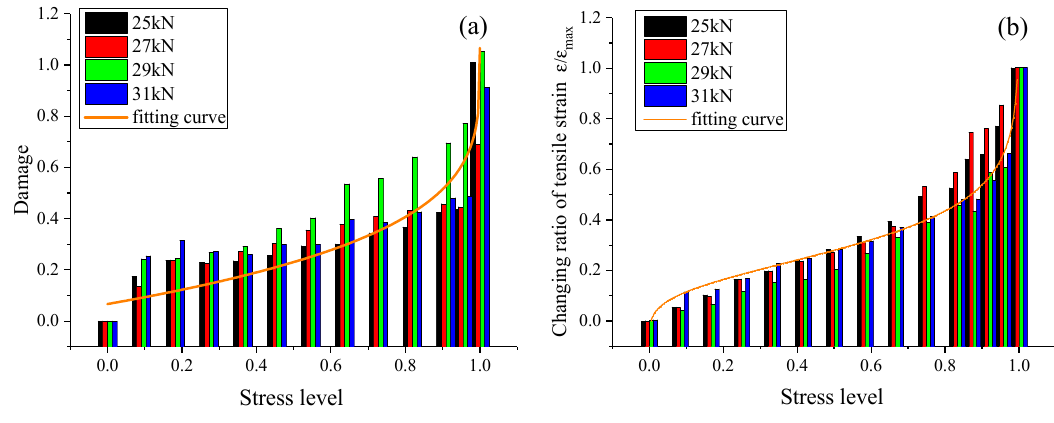
Figure 16. Strain and damage curves: ( a ) damage curve; ( b ) changing ratio curve.